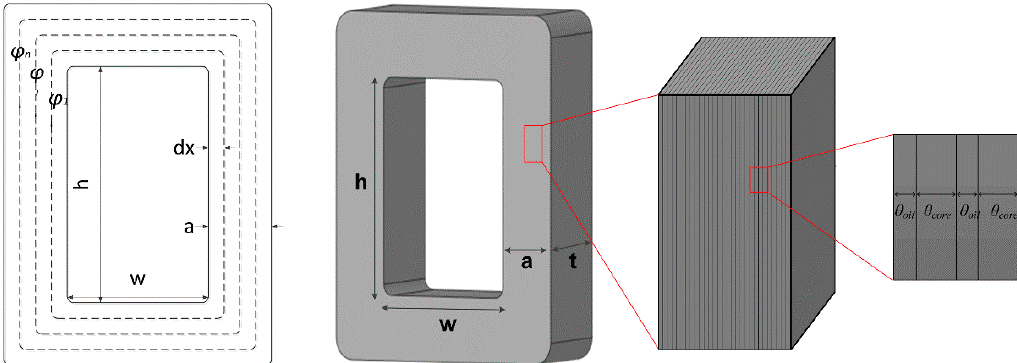
Figure 1. Structural diagram for core with flat steel sheets and oil